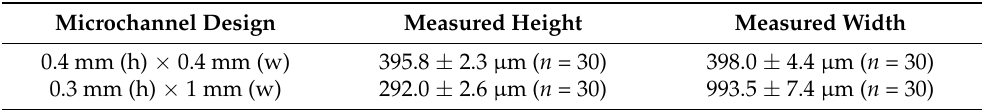
Figure 2. Microfluidic designs and devices. ( a ) Schematics and dimensions of the microfluidic channels. ( b ) CNC fabricated 48-channels, 96-well SBS-format aluminum mold. ( c ) 48-channels microfluidic device made of PDMS and bonded onto a 115 × 75 × 0.3 mm glass slide. ( d ) higher-power magnification of a single PDMS/glass channel. Table 1. Dimensions of the designs and measures of the machined